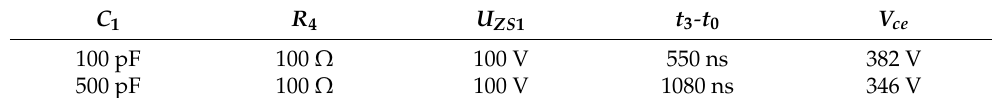
Table 2. Influence of C 1 on the turn off characteristics.